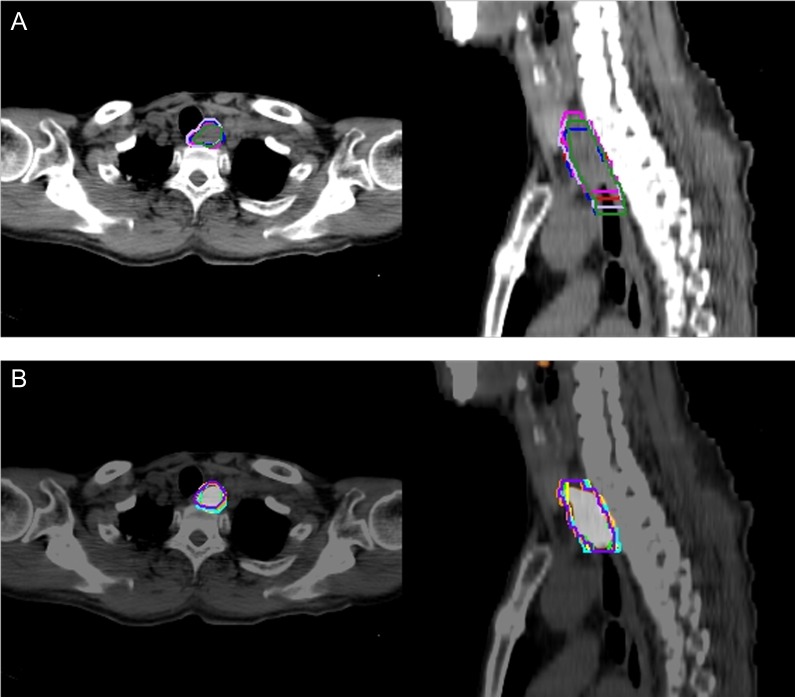
Determining the gross tumor volume (GTV) in a patient with cervical esophageal cancer (cT3N0M0). Each panel includes an axial (left) and a sagittal (right) image. (A) GTVs defined by five observers based on computed tomography (CT)-alone images. The conformality index (CI) was 0.41. (B) The CI improved to 0.59 with positron emission tomography (PET)/CT images.